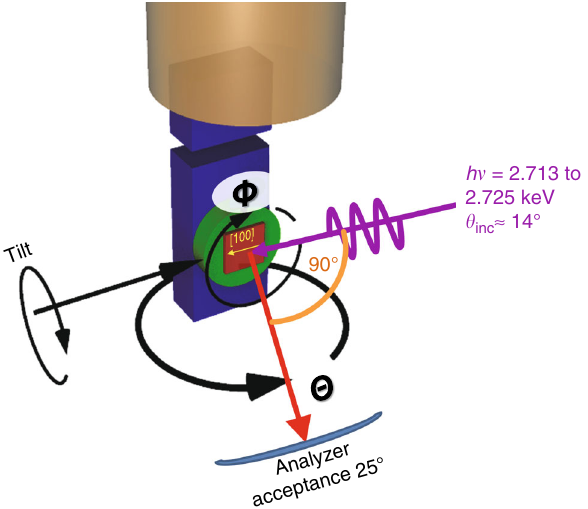
Fig. 2 The experimental geometry with various key parameters shown. Azimuthal angle Φ , polar and beam incidence angles Θ , Θ inc , and tilt angle are indicated. Light scattering plane runs along [100] crystallographic